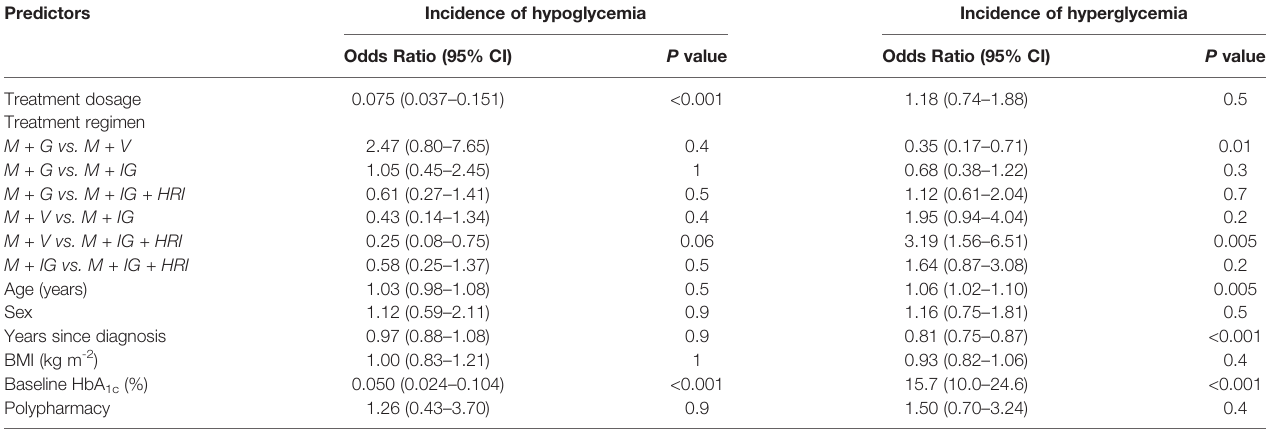
TABLE 4 | Predictors of the incidences of hypoglycemia and hyperglycemia ( N = 678 participants). Predictors